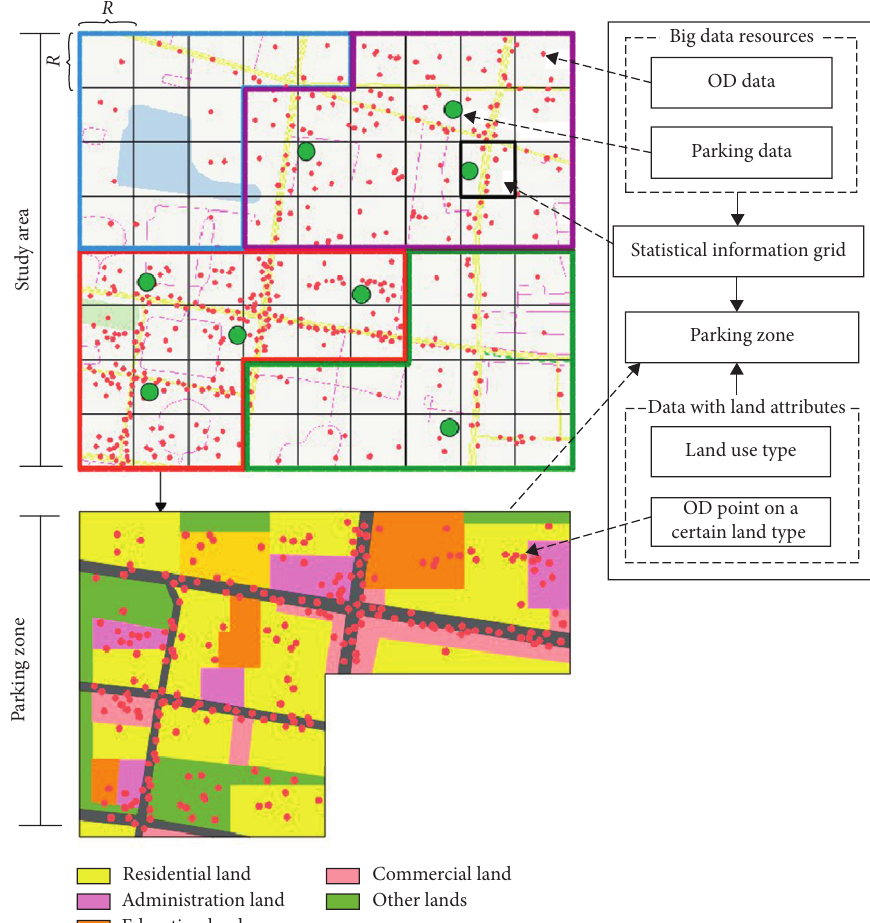
Figure 1: Concept diagram of statistical information grid and data